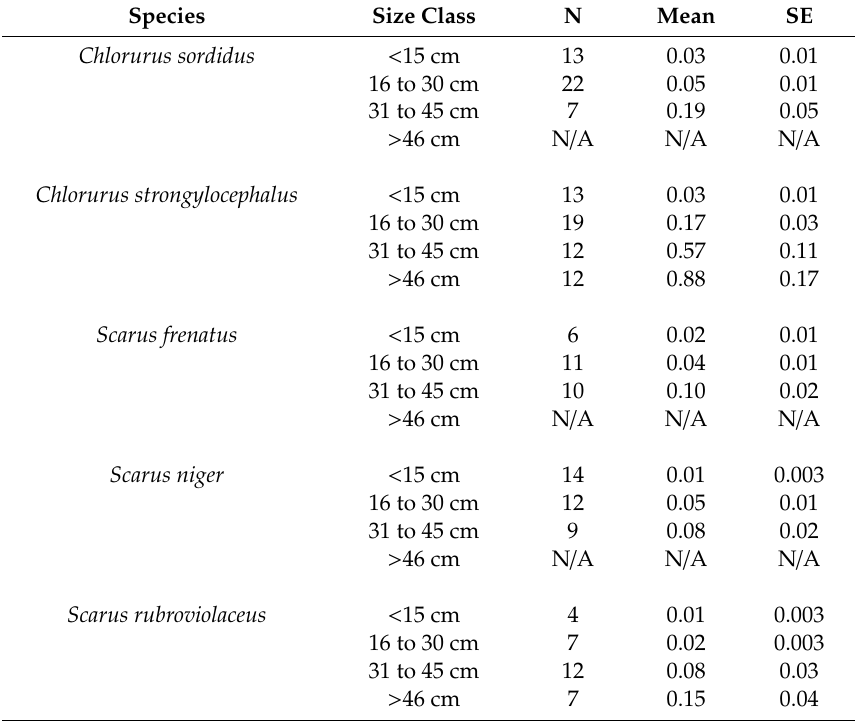
Table 2. Mean grazing scar surface areas (cm 2 ) and standard errors (SE) for four size classes of five representative Maldivian parrotfish species. Note that some individuals of Scarus frenatus were observed up to ~50 cm, but grazing scar surface areas were assumed to match those in the 31 to 45 cm size